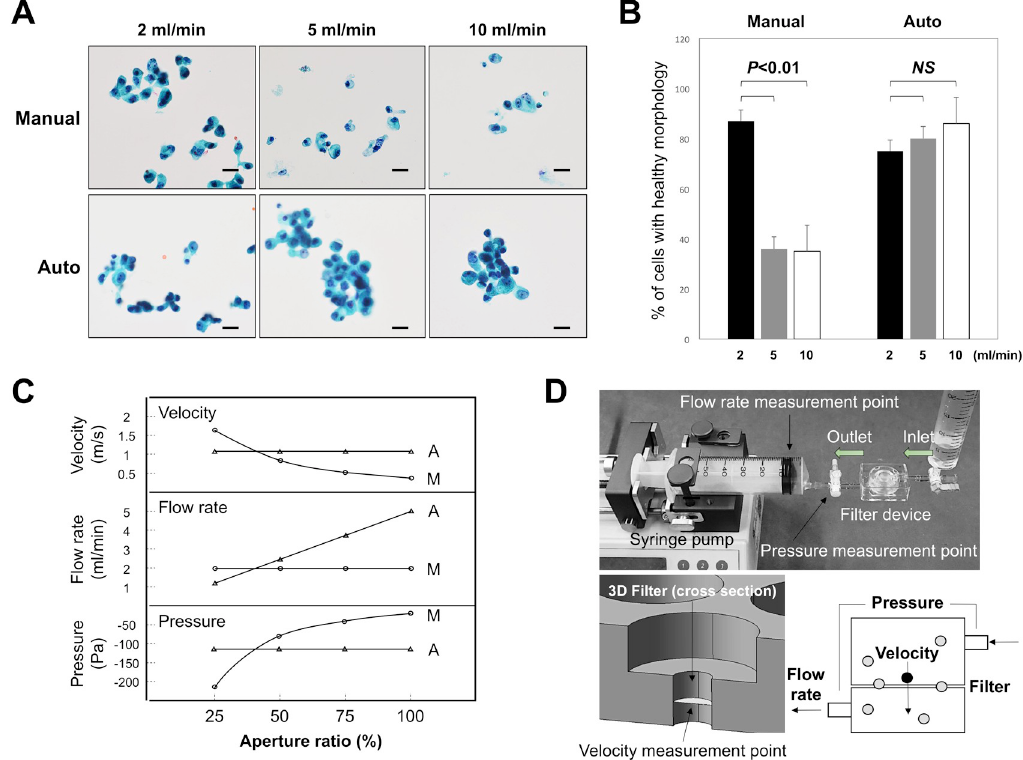
Fig 2. Comparison of the flow rate and cell morphology between manual and automated filtration apparatuses. (A) Effect of flow rate on the morphology of COLM-5 tumor cells transferred to glass slides and stained with Pap. (B) Changes in the percentage of tumor cells with healthy morphology transferred to glass slides with increasing flow rate. P < 0.01 (2 ml/min vs 5, 10 ml/min). NS: not significant. Bars = standard deviation (SD). (C) Changes in parameters such as pressure, flow rate, and velocity at each measurement point with a decreasing aperture ratio. Comparison of the manual device with a syringe pump and the automated apparatus with a pressure control system. A = automated, M = manual. (D) Overview of the manual-type microfluidic device using a syringe pump as a control to compare with the automated device. Three measurement points are shown. Schematic representations of each parameter are also shown in the right lower. Gray circles = leukocytes, Black circle =